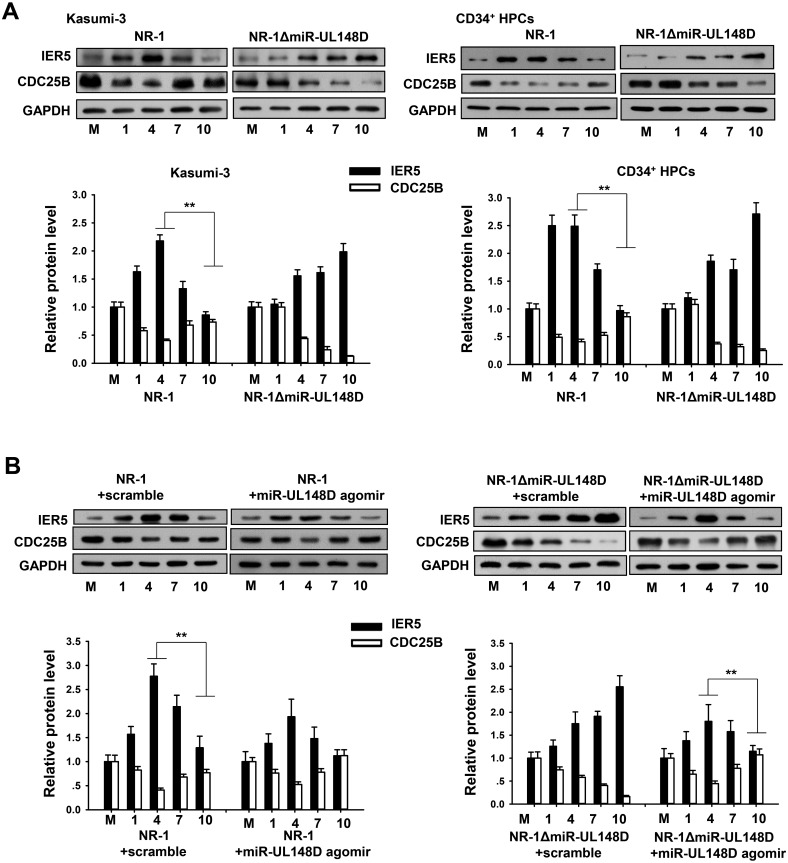
MiR-UL148D reduced IER5 level but enhanced CDC25B expression during the establishment of experimental HCMV latency.(A) Expression levels of IER5 and CDC25B in Kasumi-3 cells and CD34+ HPCs infected with NR-1 or NR-1ΔmiR-UL148D at various time points throughout a 10-day time course. (B) Restoring miR-UL148D expression via transfection with an miR-UL148D agomir suppressed IER5 expression and rescued CDC25B expression in NR-1ΔmiR-UL148D-infected Kasumi-3 cells. The miR-UL148D agomir was added to the cell culture medium 24 hours before viral infection, and the medium was then replaced daily with the inclusion of fresh agomir throughout the 10-day time course. Total cellular protein was isolated from the Kasumi-3 cells at various times after infection and detected by western blotting. The results from Kasumi-3 cells infected with NR-1 virus are shown as a control. Values are shown as the mean ± SEM (n = 3). **, P<0.01.